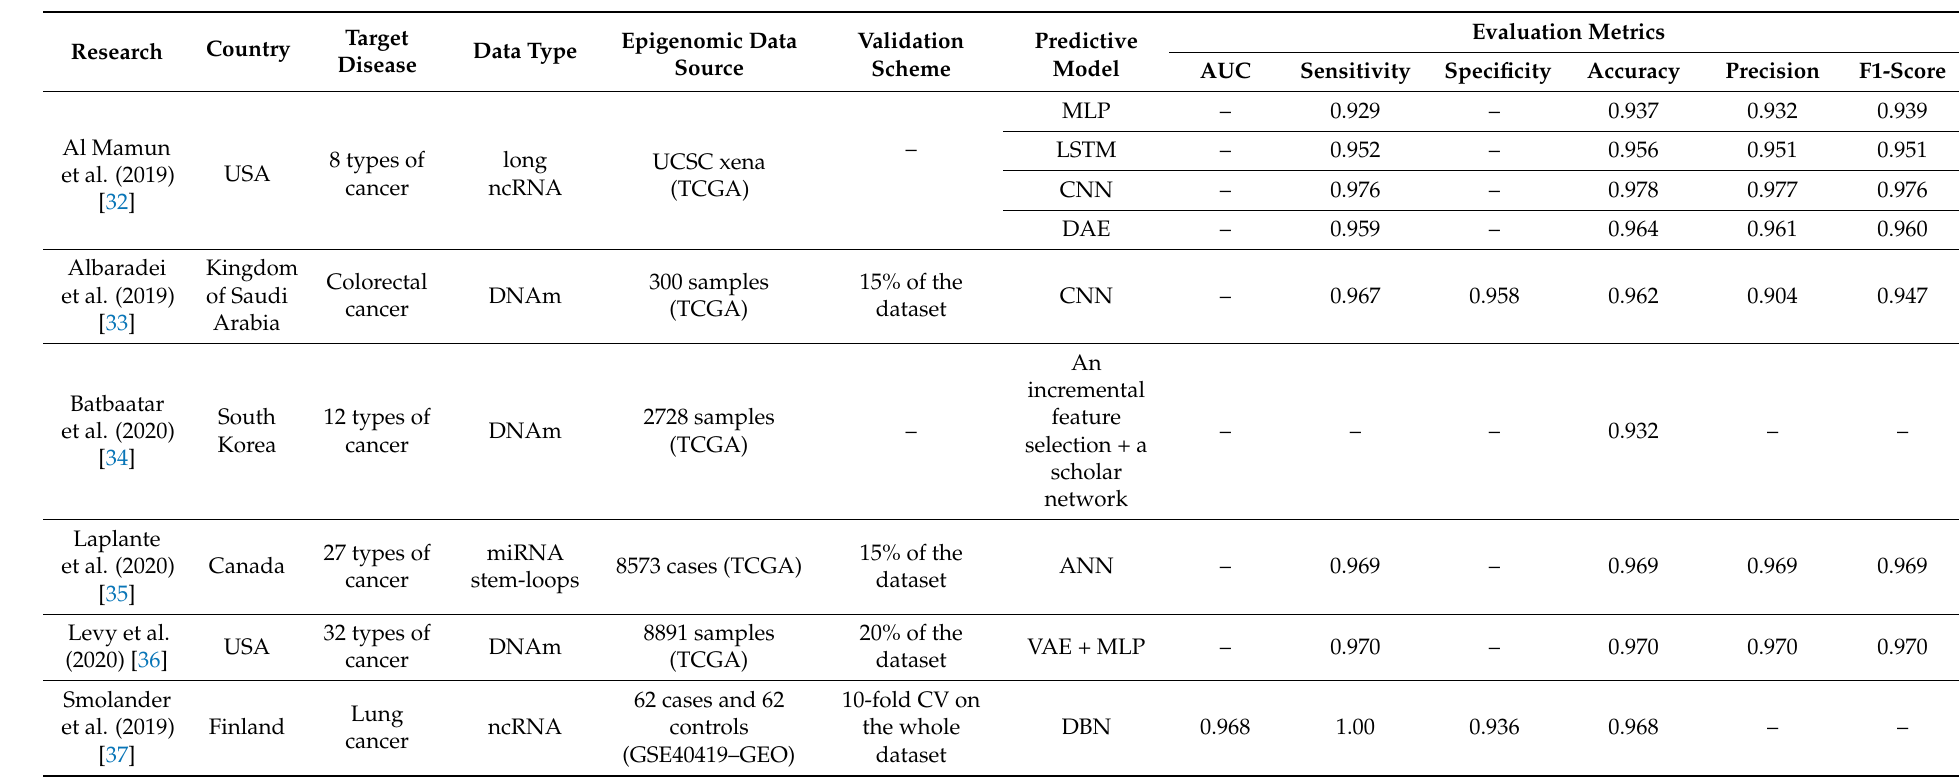
Table 3. Comparison of DL models for disease subtype classification using epigenomic